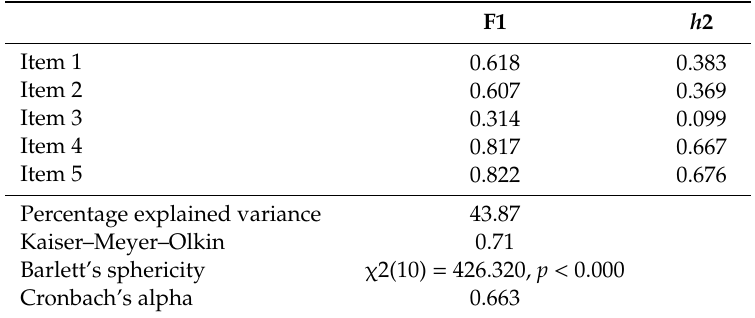
Figure 1. Scree plot of factor analysis of the original Brief Illness Perception Questionnaire (BIP-Q5) model. Table 2. Factor structure, communalities (h 2 ) eigenvalues, Cronbach’s alpha and percentage of explained variance ( n = 505). Extraction method: principal components factoring.